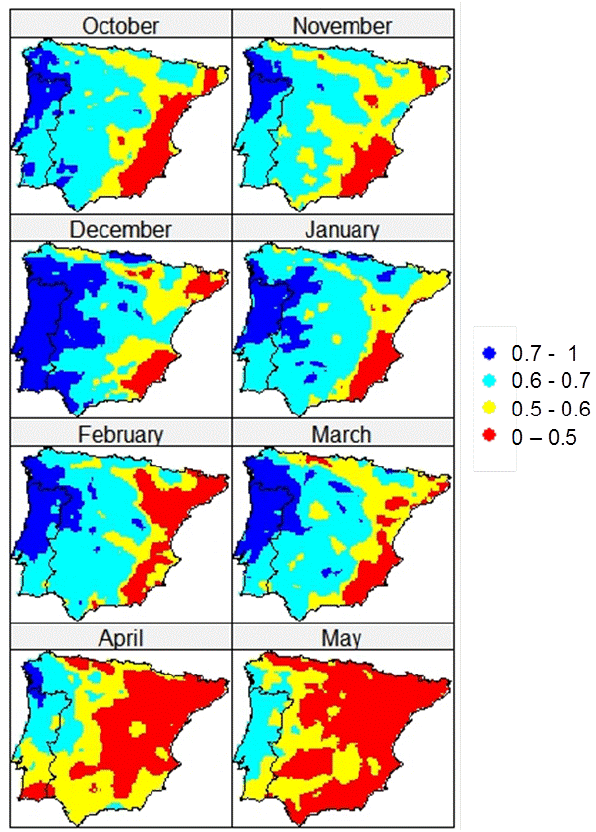
Figure 5. Spatial and temporal distribution of D of Willmott applied to predicted and observed precipitation for each month from October to May. High values near 1 represent a better agreement between reconstruction and observations. Table 1. Global monthly normalised MAE, MBE and D indexes from October to May. Each index was averaged over all the 5828